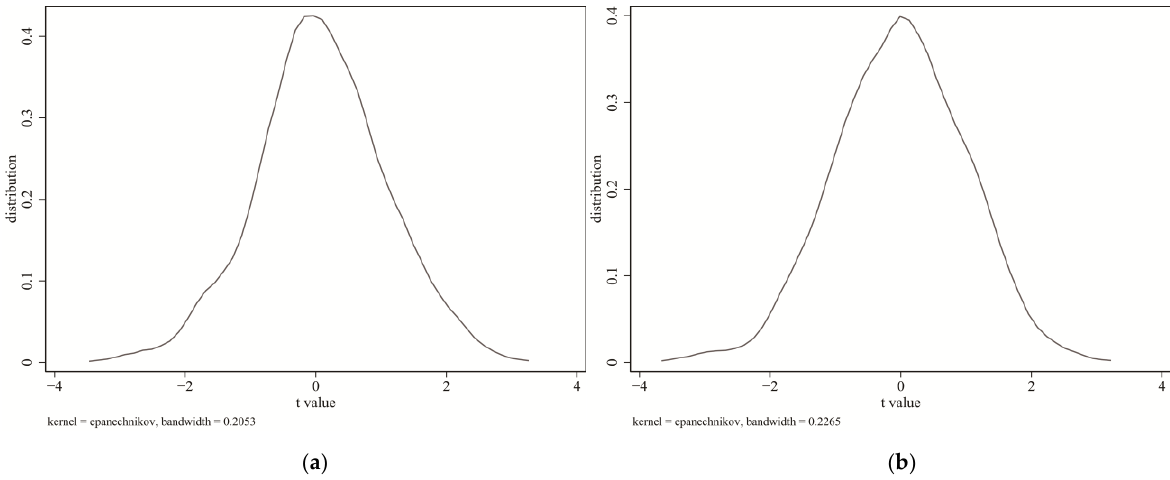
Figure 3. Placebo test. ( a ) shows the coefficient’s t distribution of DID calculated in the placebo test; ( b ) shows the coefficient t distribution of W × DID calculated in the placebo test.